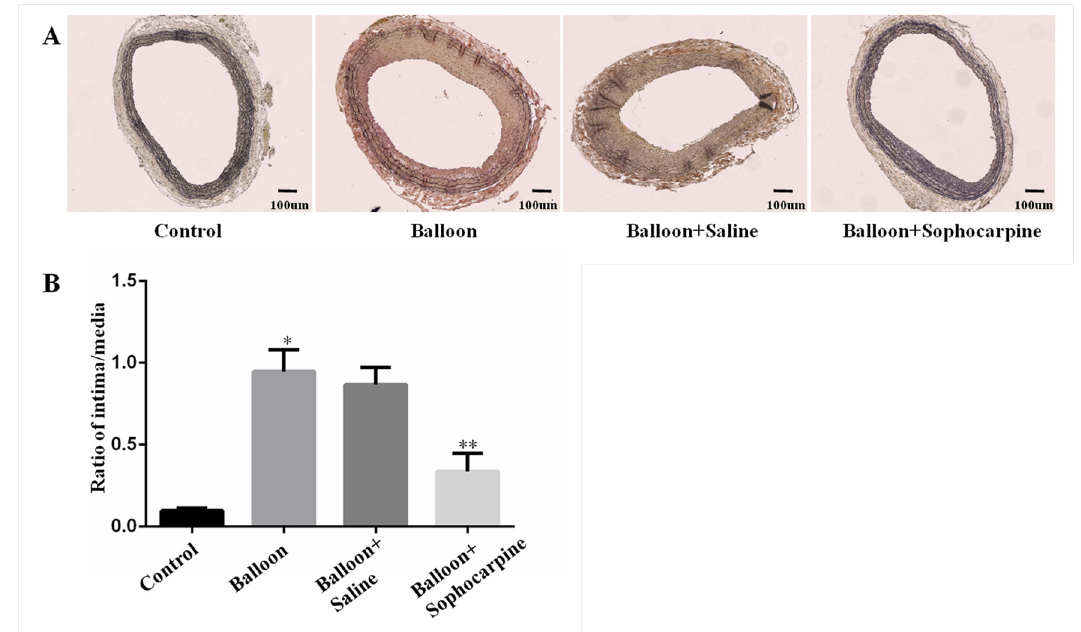
Figure 1. Degree of stenosis in carotid arteries treated differently. ( A ) Verhoeff–Van Gieson stained sections of carotid arteries from the rats in various groups (×100). ( B ) The intima-to-media ration of carotid arteries from the rats in various groups. * p < 0.01 versus the control group, ** p < 0.01 versus the balloon group.